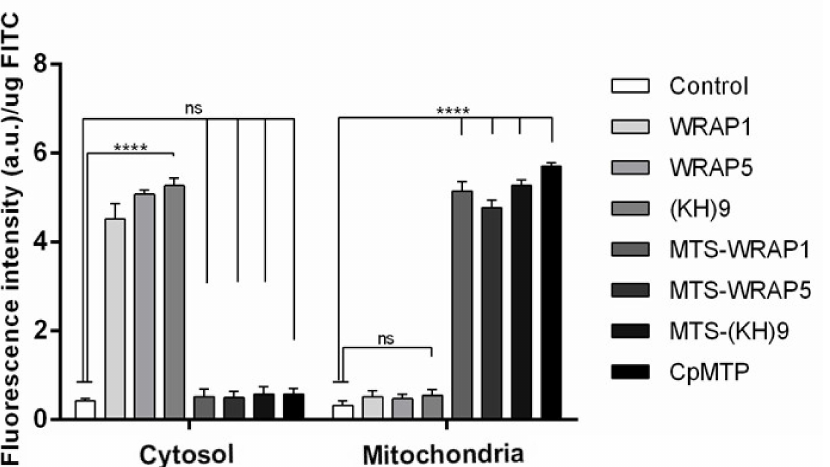
Figure 4. FITC fluorescence intensity (arbitrary units, a.u.) in the cytosol and mitochondria of HeLa cells after 12 h transfection mediated by WRAP1/pND1, WRAP5/pND1, (KH)9/pND1, MTS- WRAP1/pND1, MTS-WRAP5/pND1, MTS-(KH)9/pND1 and CpMTP/pND1 systems conceived at N/P ratio of 5. Untreated cells were used as control. The data were obtained by calculating the average of four independent experiments and are presented as mean ± SD; not significant (n.s.) and **** p < 0.0001. A comparison between cytosol and mitochondria for corresponding complexes was performed for all pND1-based systems: not significant for control and **** p < 0.0001 for all systems.